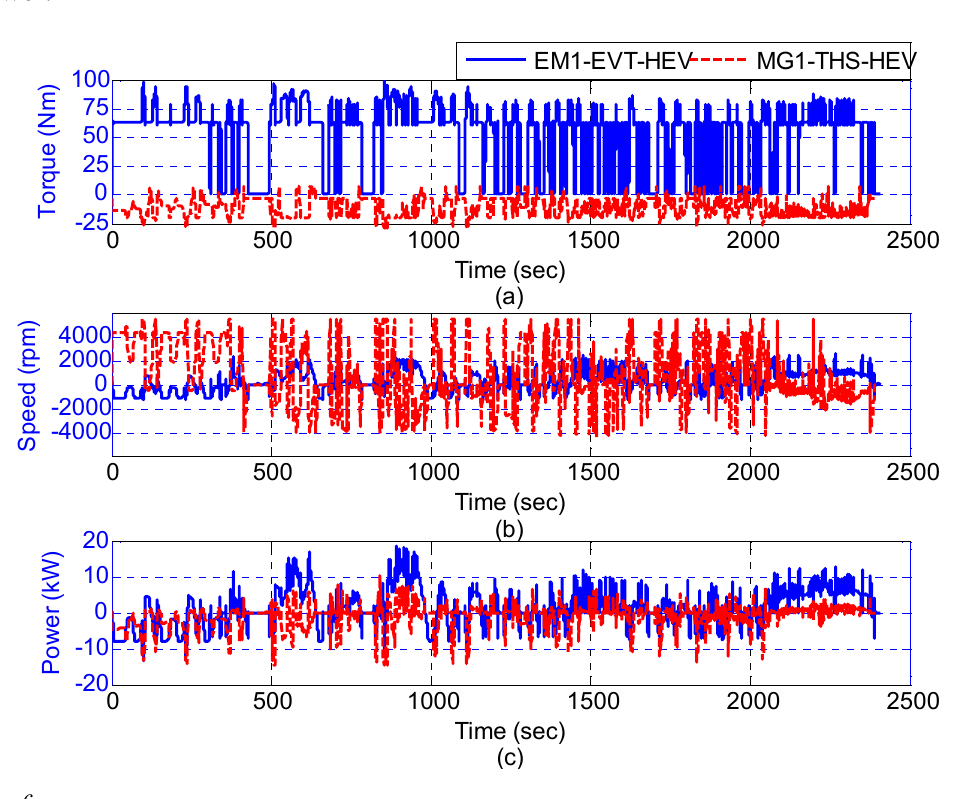
Figure 18. EM1/MG1 Performances of EVT-HEV and Prius HEV: ( a ) Torque; ( b ) Speed; ( c )